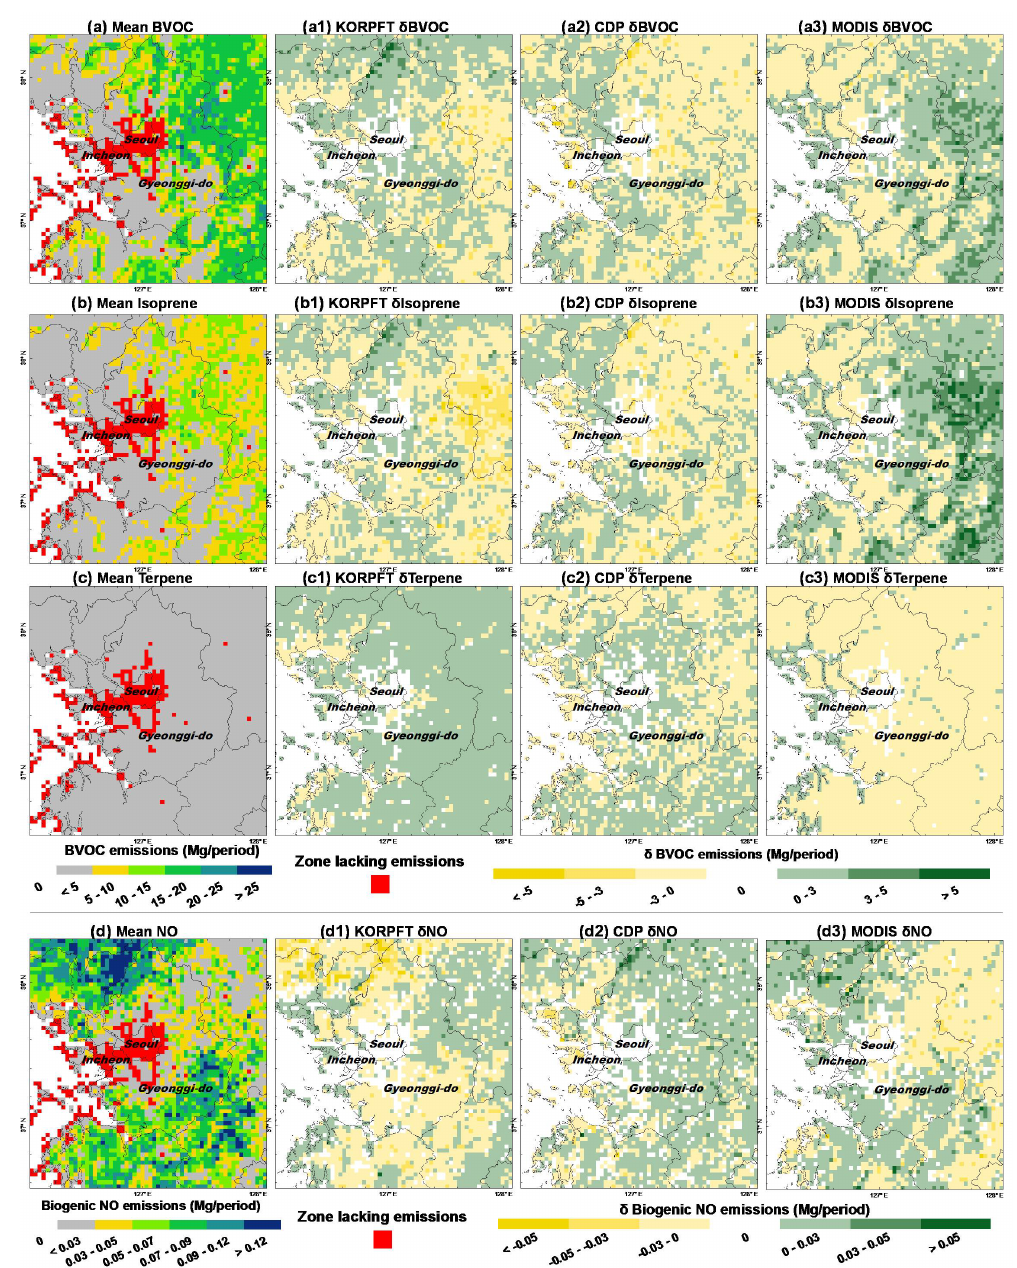
Figure 5. Spatial distribution of biogenic emission deviations for each PFT scenario. The red zones denote the zones lacking biogenic emissions during the MEGAN emission